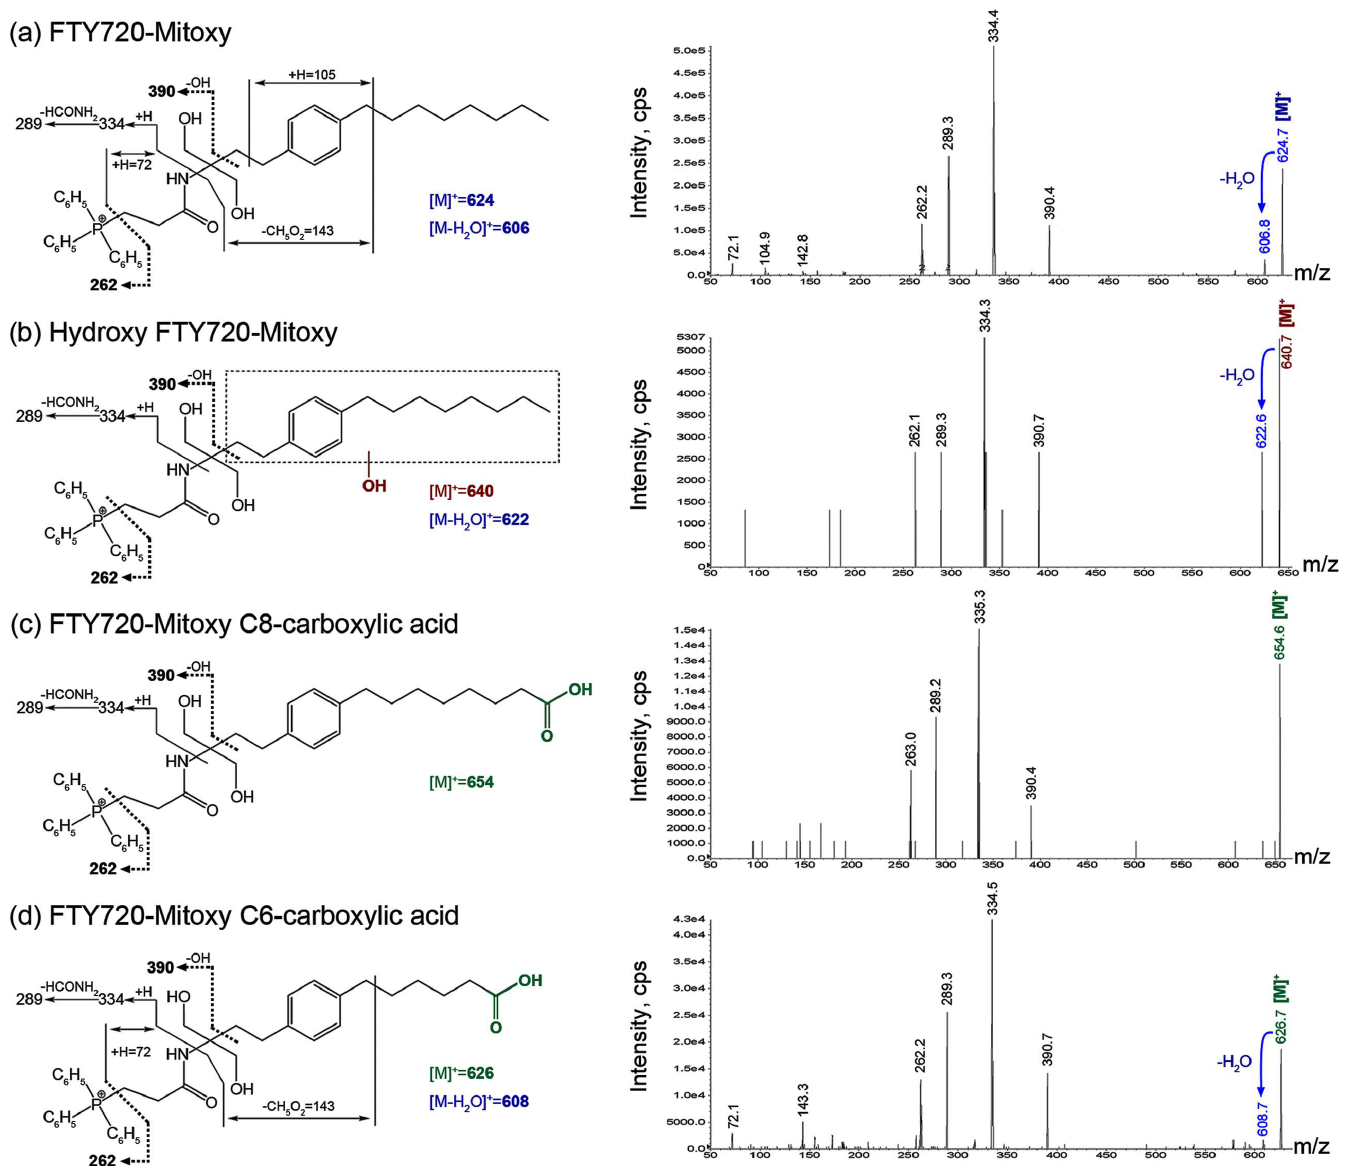
Fig 4. Proposed FragmentationScheme and Mass Spectrum for FTY720-Mitoxyand its Metabolites. Mass spectrometryof FTY720-Mitoxy and metabolitesdetected[M + ] molecular ions. Blue text and arrows indicatelosses of H 2 O from[M] + . The ion with a hydroxyl group is shown in red . Ions includinga carboxylic acid are shown in green